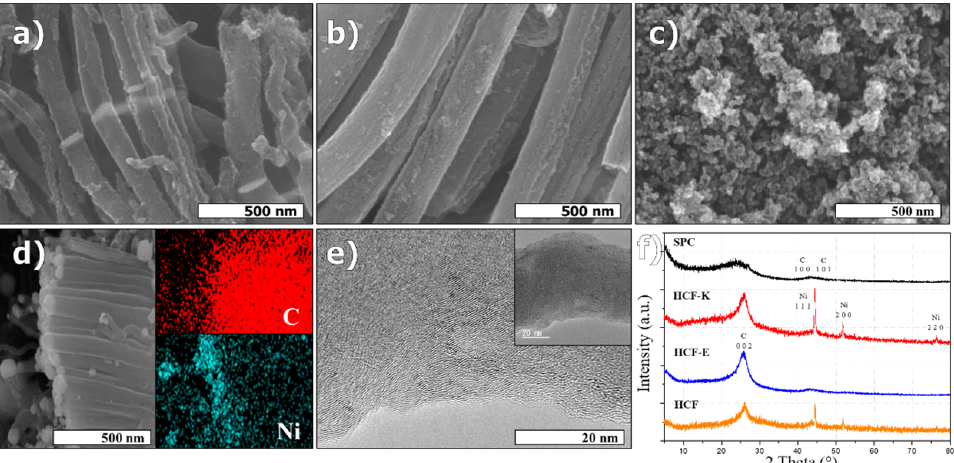
Figure 3. HCFs after modification. ( a ) HCF-K after activation with KOH. Segments of the fibers present Ni metal nodules (brighter segments of the fiber). ( b ) HCFs after Ni etching with acid (HCF-E). The HCF bundles unwrapped and metal nodules are not perceived. ( c ) Carbon material obtained inside the SP reactor (o-dichlorobenzene as precursor). ( d ) EDX of the fibers showing the Ni particles at the extremes of the fibers. ( e ) TEM micrograph of the outer border of a carbon fiber. ( f ) XRD pattern of post-treated HCFs and solution plasma carbon (SPC), also post treated at 400 °C under Ar and H2 atmosphere.